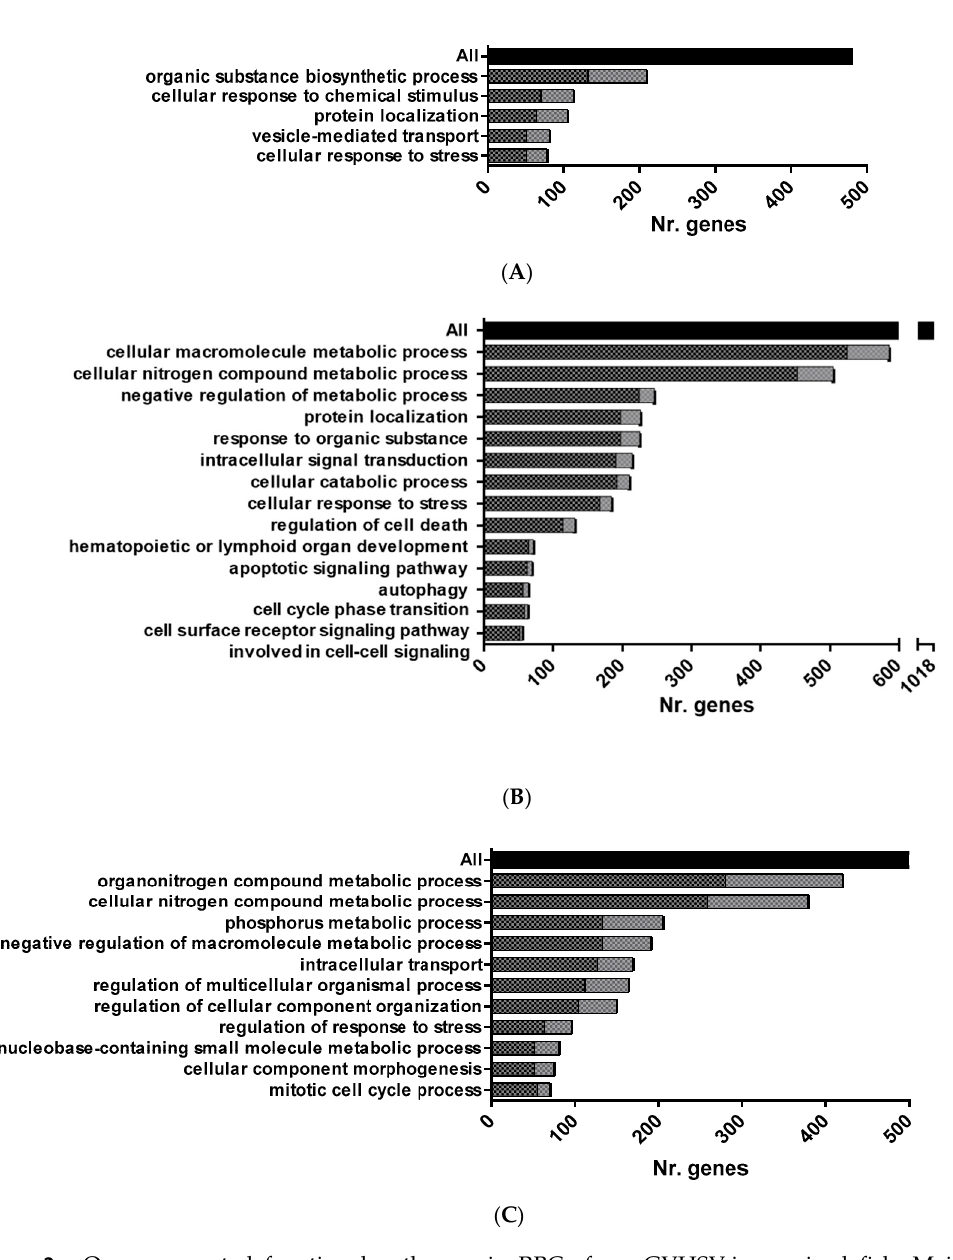
Figure 2. Overrepresented functional pathways in RBCs from GVHSV-immunized fish. Main overrepresented GO Biological Process Database terms were identified by the Cytoscape ClueGO. ( A ) Overrepresented pathways in HK-RBC transcriptome profile. ( B ) Overrepresented pathways in PB-RBC transcriptome profile. ( C ) Overrepresented pathways in PB-RBC proteome profile. Black squares represent upregulated genes or proteins, and gray squares represent downregulated genes or proteins identified in each GO term. The black bar represents the total number of genes or proteins with FDR < 0.05 and FC p -value < 0.05. All GO terms overrepresented were statistically significant with p -value <